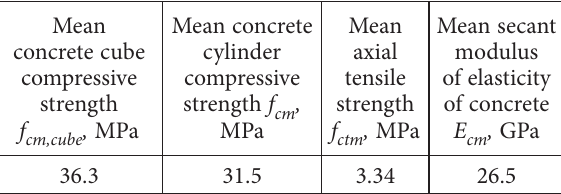
Table 3. Mechanical properties of concrete